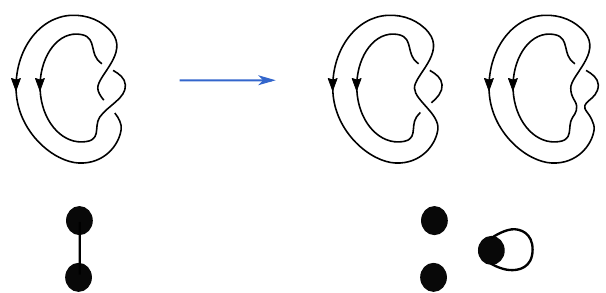
Figure 2. The e(cid:11)ect of disk boundary crossing on a simple quiver corresponding to two disks linking once. Since we use only symmetric quivers, we simplify pictures and let an unoriented line between nodes denote a pair of arrows in opposite